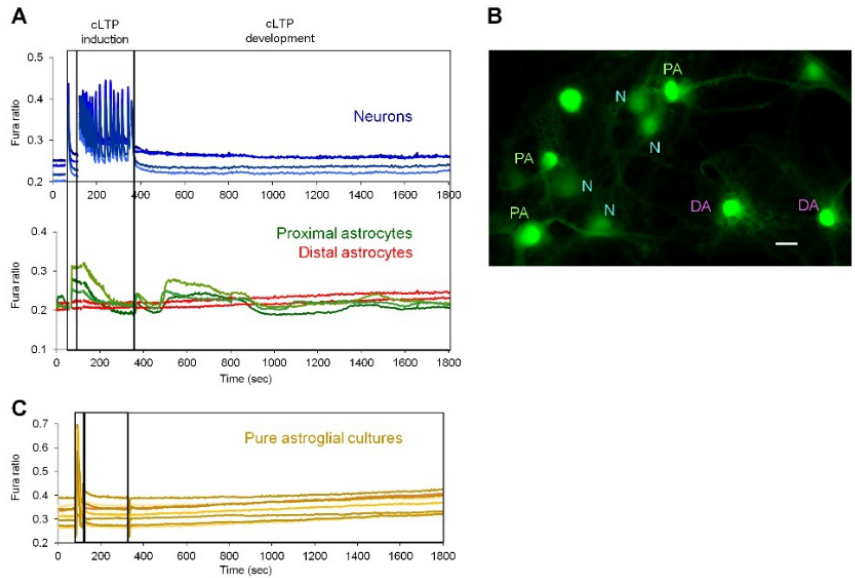
Figure 4. Delayed Ca 2+ signals in proximal-to-neurons astrocytes induced by cLTP. ( A ) Ca 2+ signals were detected by Fura-2 single cells imaging and analyzed separately in neurons (blue traces) and astrocytes (green and red traces). Note appearance of delayed Ca 2+ signals in astrocytes which are in close apposition with neurons (green traces in panel A and “PA” (Proximal Astrocytes) label in B ) but not in distal astrocytes, which are not in contact with neurons (“N”) (red traces in panel A and “DA” label in panel B ). Representative traces and image are shown of cLTP induction experiments from 2–3 coverslips (technical replicates) for each of three independent culture preparations (biological replicates). Bar, 10 µ m. C , Ca 2+ signals were not detected in pure astroglial cultures stimulated with cLTP